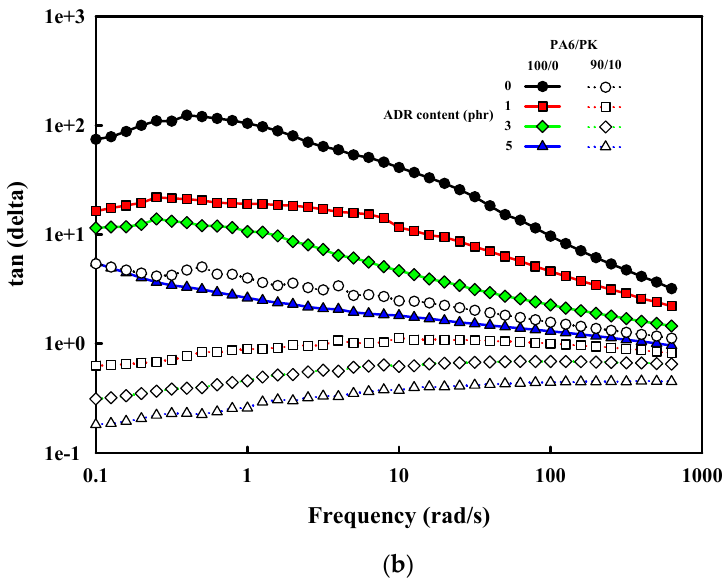
Figure 8. Rheological properties of PA6 and PA6/PK blend with chain extender, ADR: ( a ) complex viscosity; ( b ) loss tangent.